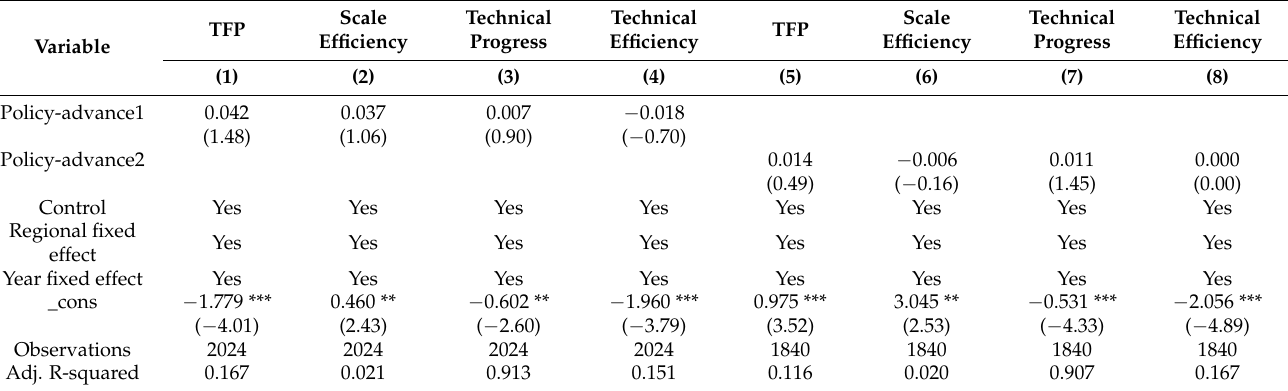
Table 5. Placebo test.